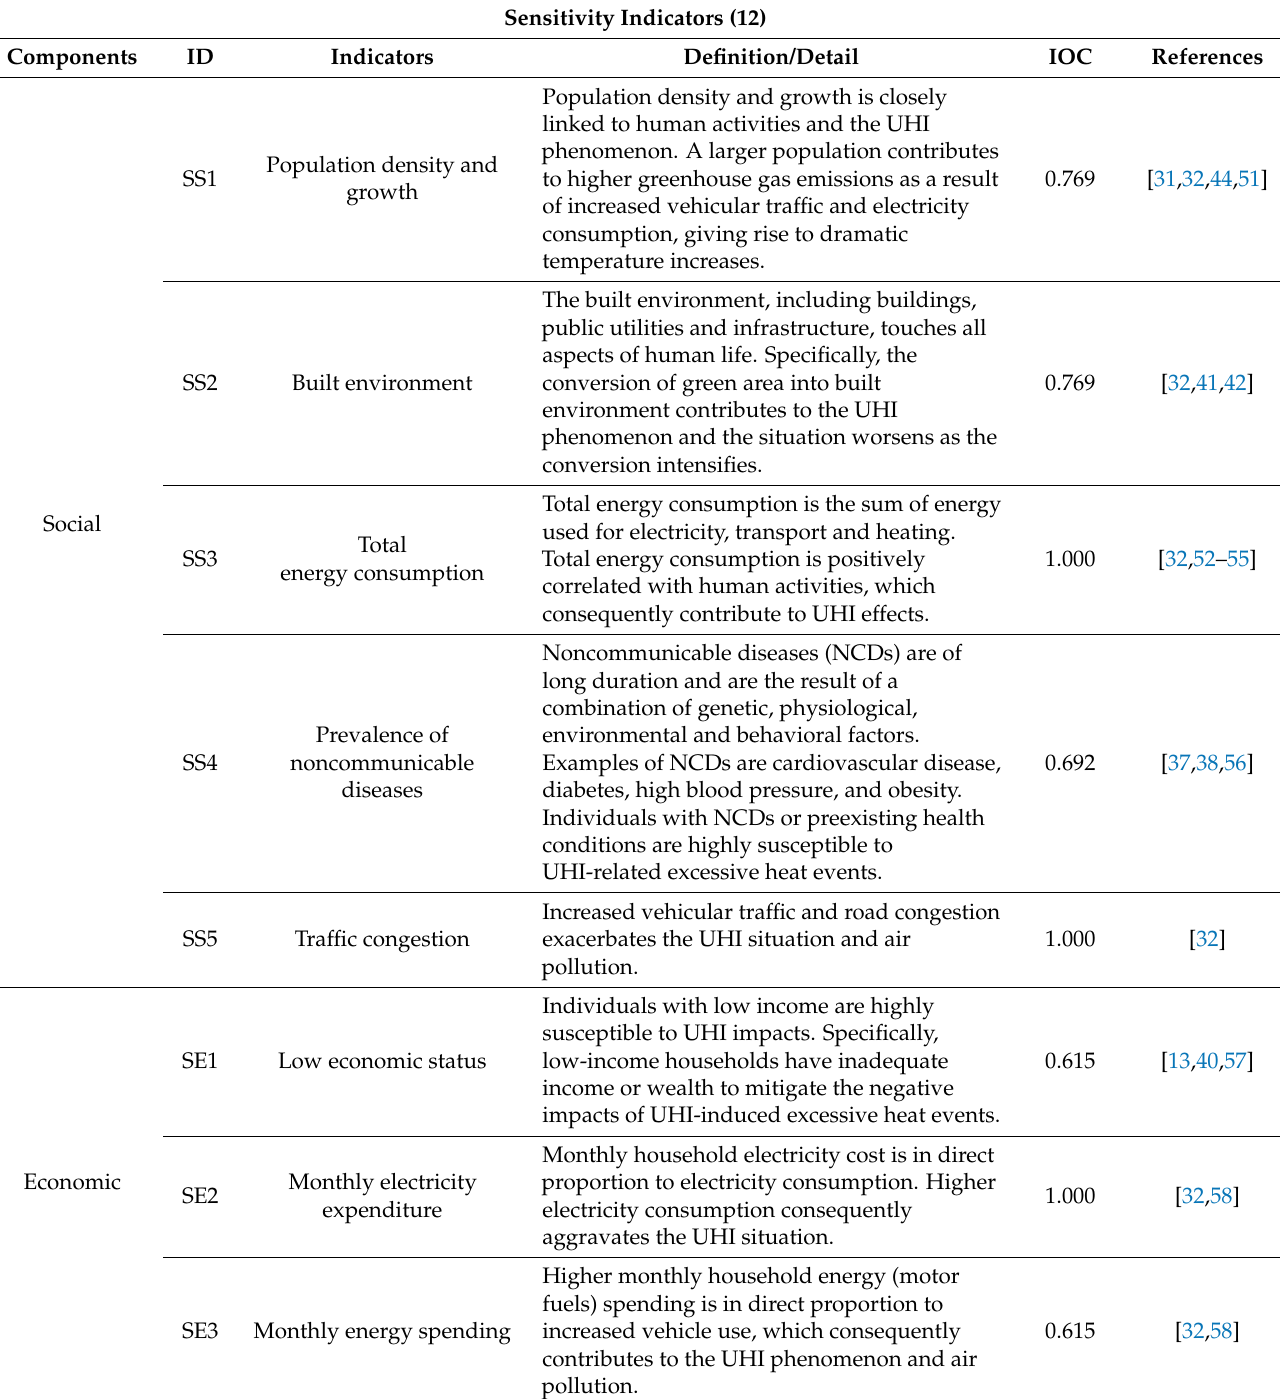
Table 3. The UHI sensitivity indicators, definitions and expert-validated IOC